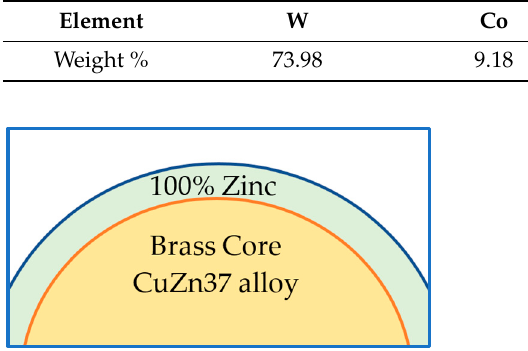
Table 3 . Physical properties of tungsten carbide . Figure 5 . Schematic of zinc - coated brass wire . Figure 5. Schematic of zinc-coated brass wire. Table 2. Brass wire–CuZn37 alloy compositions. Table 2 . Brass wire – CuZn37 alloy compositions . Table 4 . Properties of zinc - coated brass wire .